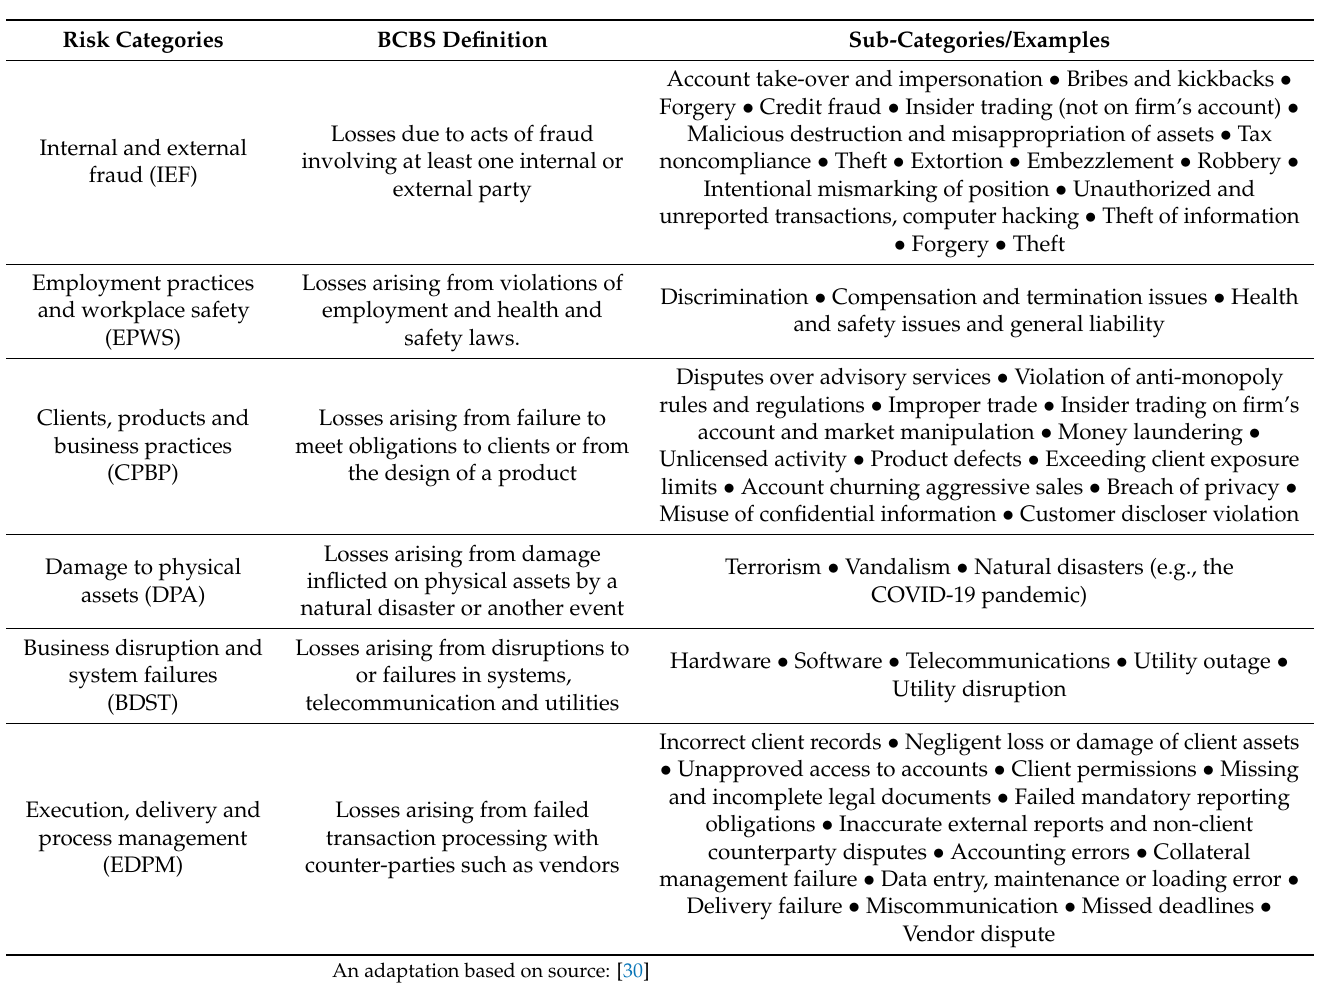
Table 1. The BCBS taxonomy of operational